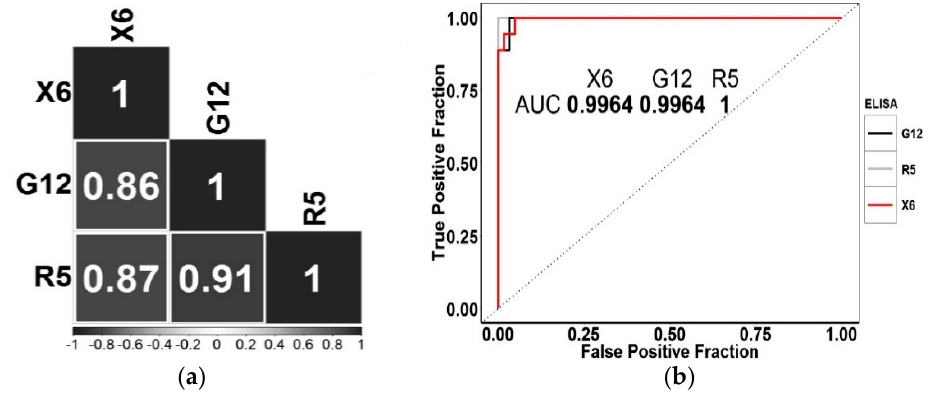
Figure 5. Gluten content comparison results obtained using various methods: ( a ) correlogram obtained by analyzing the gluten content using various test systems. The squares indicate the value of the Pearson correlation coefficient; ( b ) ROC curves obtained from the analysis of products using various ELISA.